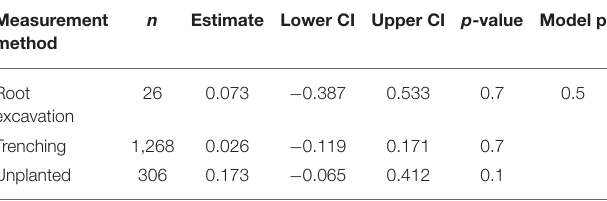
TABLE 2 | Effect sizes (LnRR) of SRR to N fertilisation for different respiration measurement methods. Measurement method